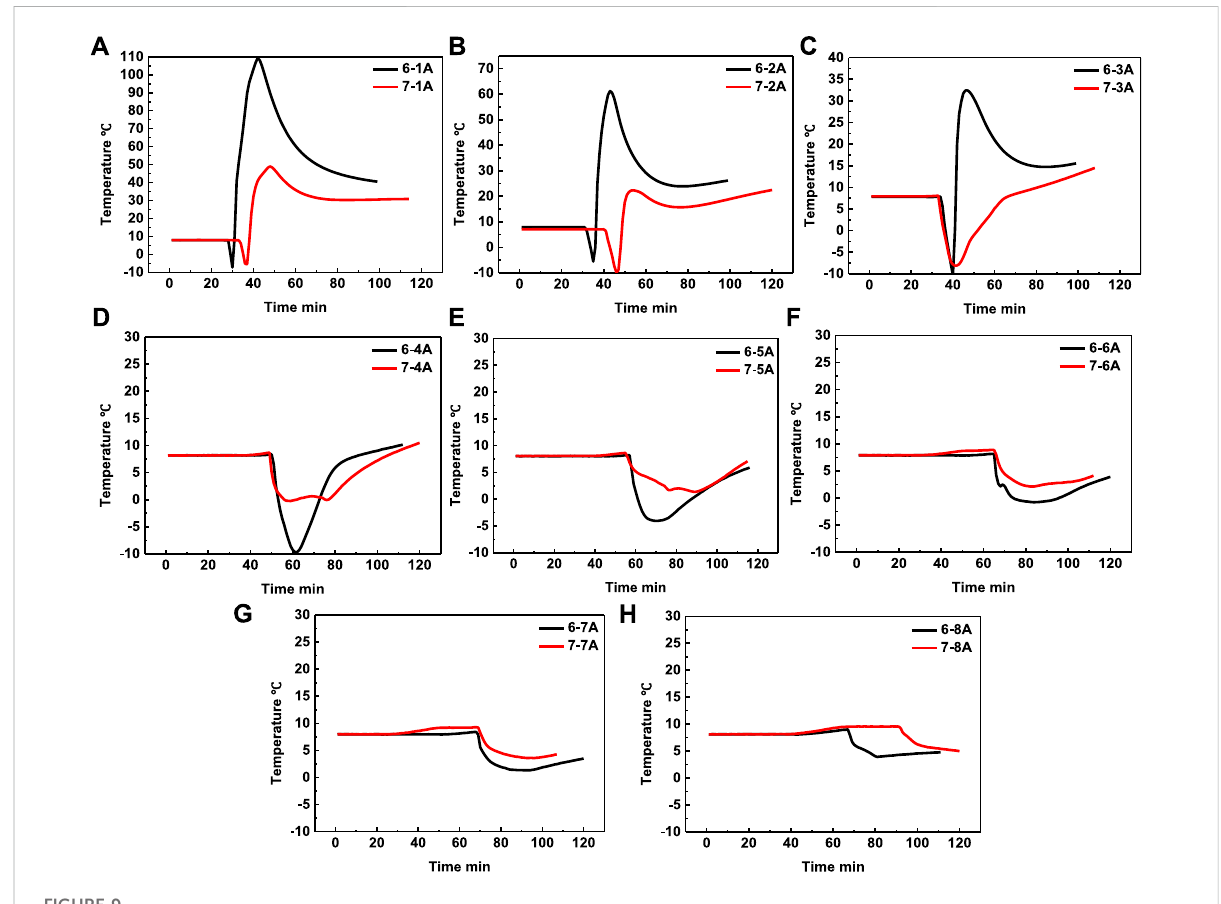
FIGURE 9 Temperature comparison in experiment 6 and experiment 7 at positon 1A (A) , positon 2A (B) , position 3A (C) , position 4A (D) , position 5A (E) , position 6A (F) , position 7A (G) and position 8A (H) ,